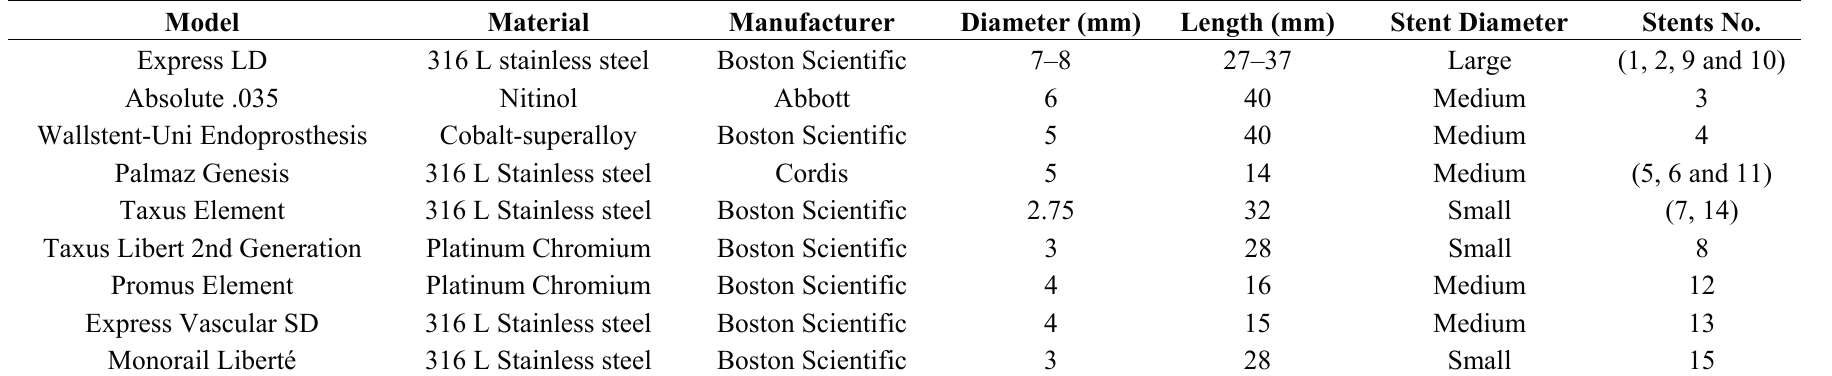
Table 2. Details of the examined stents.